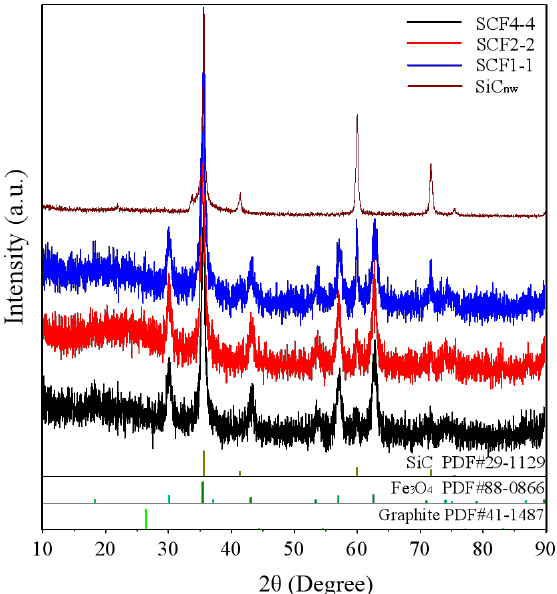
Figure 1. XRD spectra for all samples